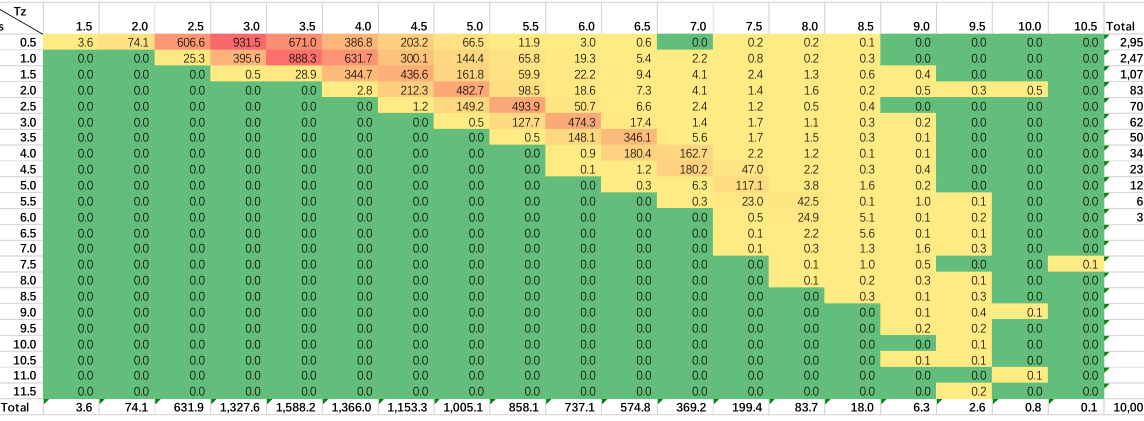
Figure 15. Wave scatter diagram at Site B.